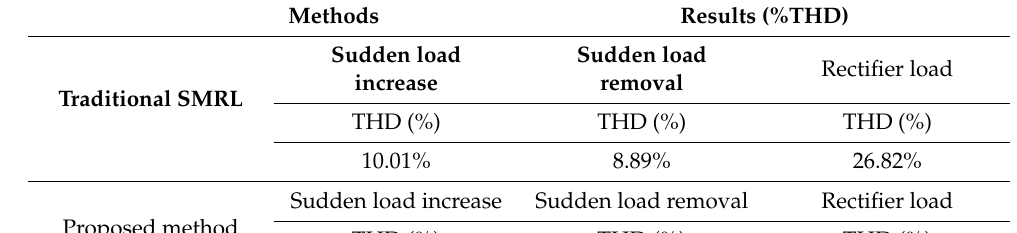
Figure 19. Experimental AC output voltage for the proposed method under rectifier load (vertical: 100 V/div and 5 ms/div).